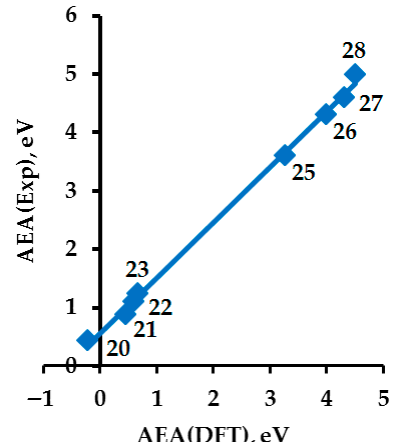
Figure 6 . Correlations between DFT calculated and experimental values of AEA: AEA(Exp) =